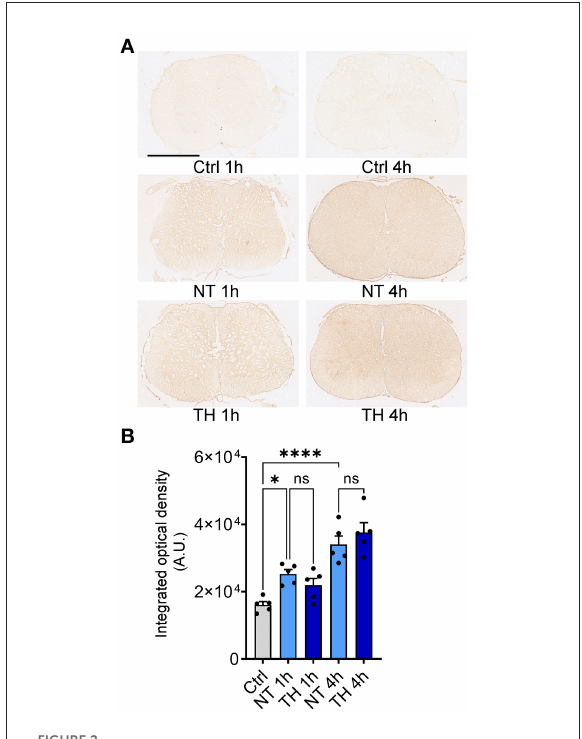
FIGURE2 Serum non-specific immunoglobin G (IgG) leaked into the neural tissue after SCI. (A) Representative immunohistochemistry images of leaked serum IgG in the injured spinal cord (non-epicenter) 1 and 4h post-SCI. Scale bar: 1mm. (B) The integrated optical intensity of IgG in the impact and adjacent spinal segments with TH 1 and 4h post-SCI. Normally, serum IgG does not exist in neural tissue. The optical density in the Ctrl group is the value of the tissue background. n = 5 mice per group, data are shown as the mean ± SEM; ns, non-significance; * P = 0.002, **** P < 0.0001, NT 1h & TH 1 h: P = 0.716, NT 4h & TH 4 h: P = 0.656; nested, one-way ANOVA with Bonferroni’s post hoc